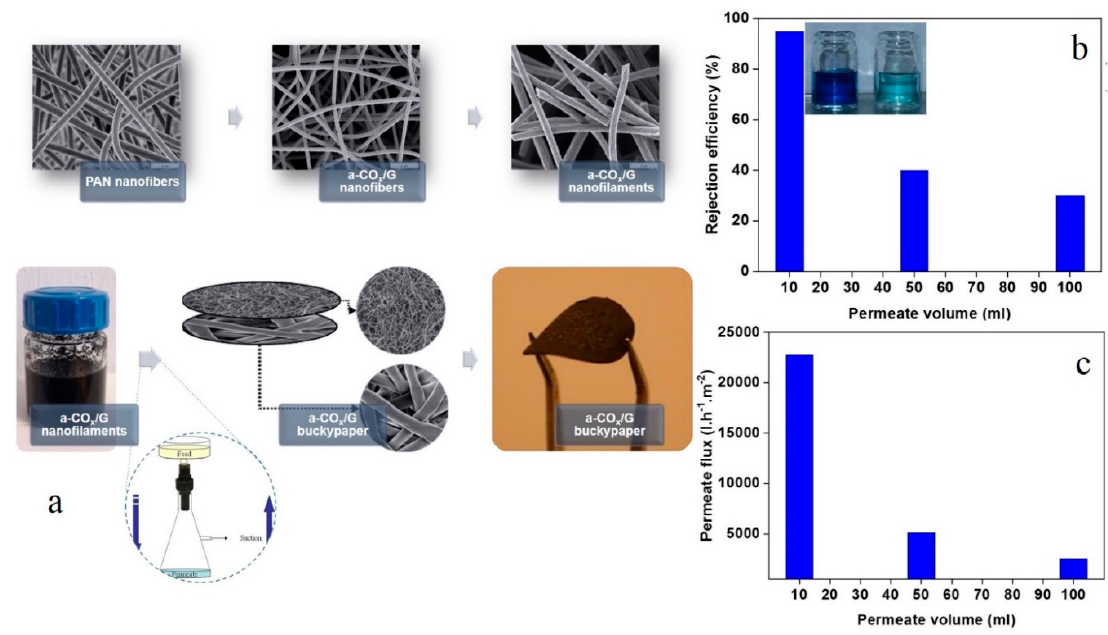
Figure 6. ( a ) The schematic illustrates the construction procedure of the a-CO x /G adsorbent membrane (the scale bars represent 2 µm and 1 µm for the first two and third images, respectively). ( b ) MB removal efficiency of the a-CO x /G adsorbent (the inset shows the feed and permeate samples, respectively) and ( c ) the solution flux of the a-CO x /G adsorbent. Reproduced with permission [117]. Copyright 2018, John Wiley and